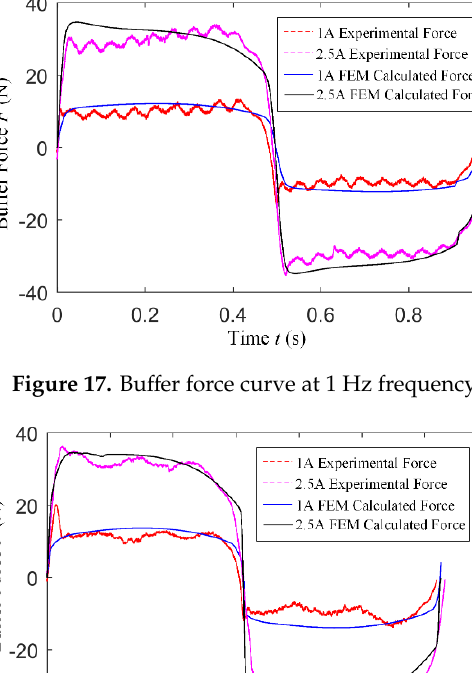
Figure 16. Displacement–velocity curve of the MR buffer.